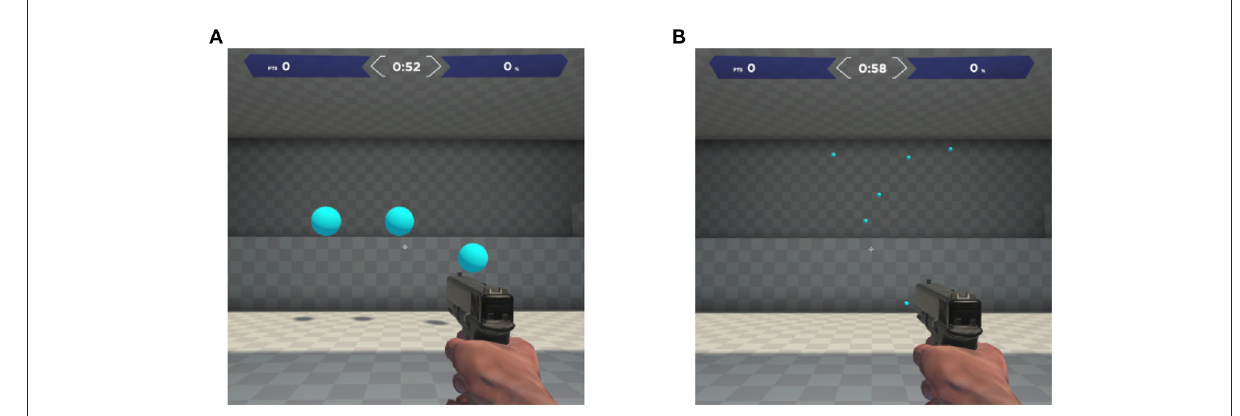
FIGURE1 Screenshots from Aim Lab TM , displaying a single frame from the: (A) Gridshot and (B) Sixshot